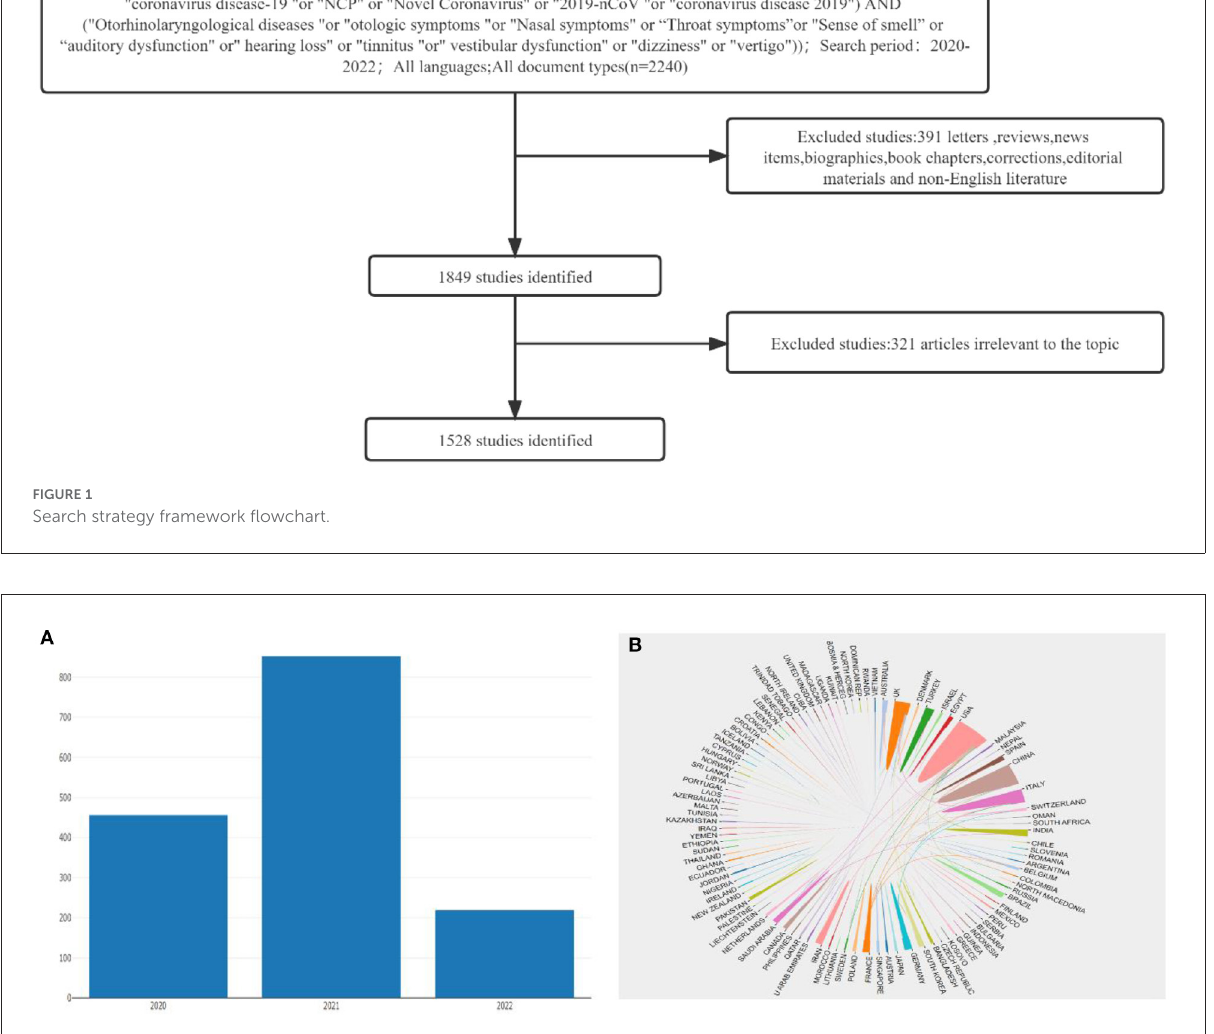
FIGURE2 (A) Annual number of publications. (B) The geographic dispersion of nations/regions. Cooperation between nations/regions.